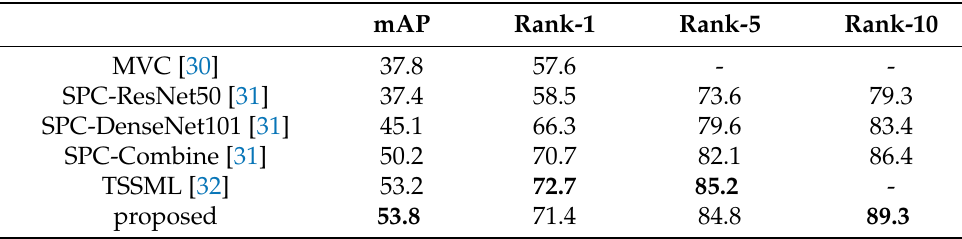
Table 8. Performance comparison on the DukeMTMC-reID